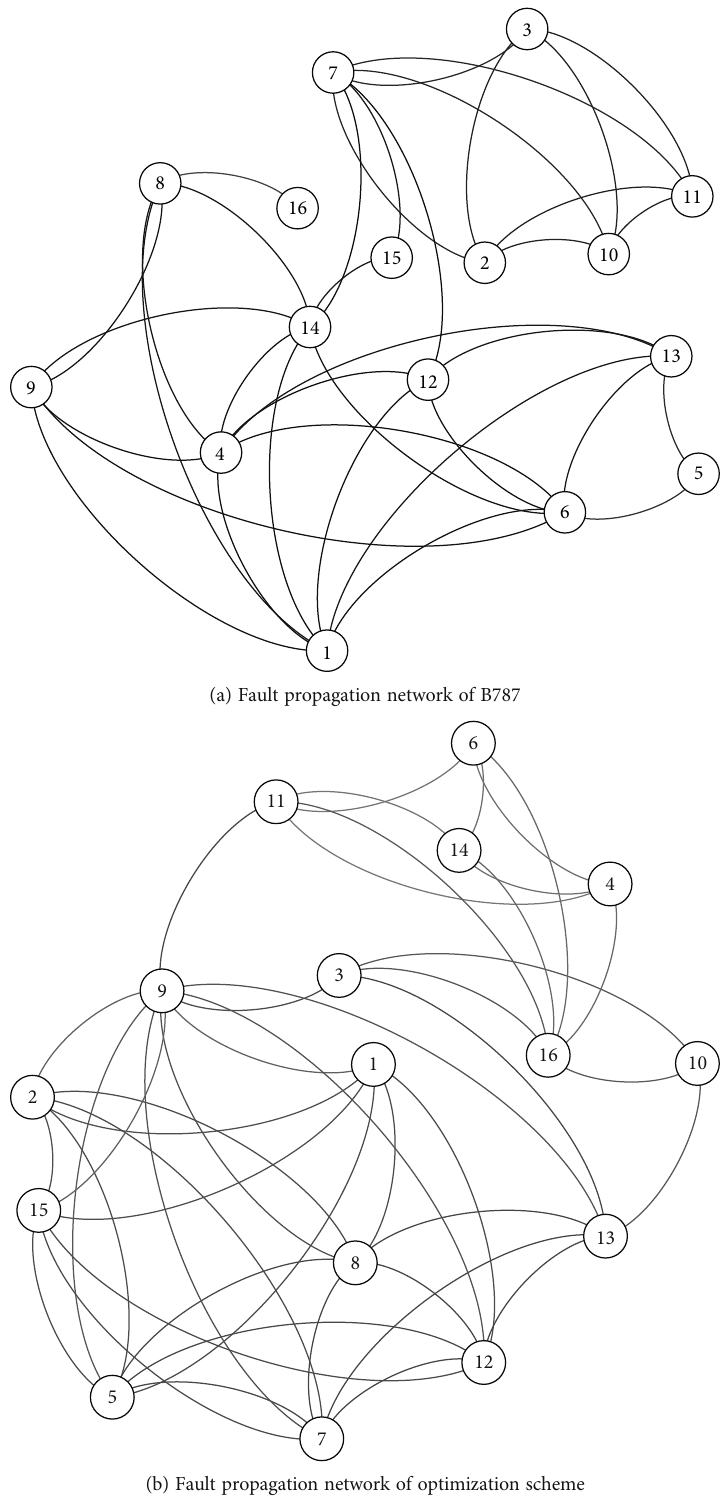
Figure 5: Fault propagation network of IMA system with di ff erent resource allocation